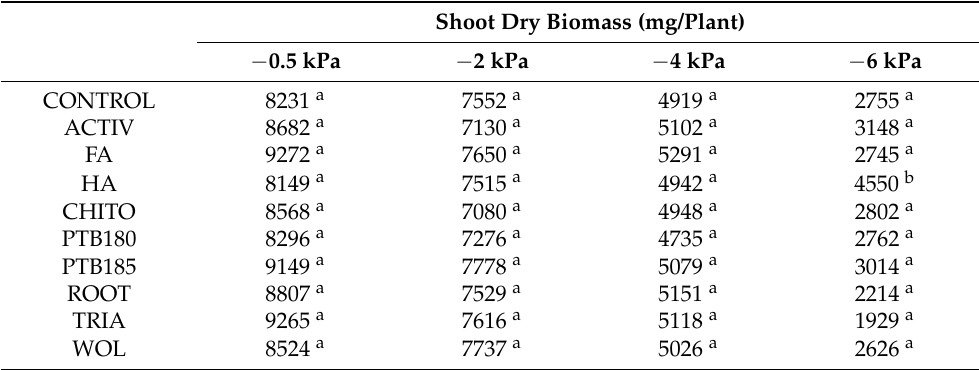
Table 11. Effect of biostimulants and substrate water potentials on the shoot dry biomass of Batavia lettuce under conventional management.